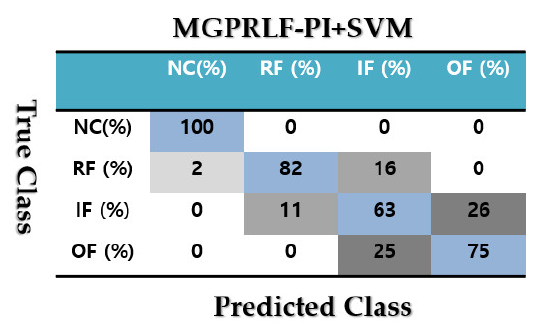
Figure 11. The average accuracies of crack identification using the MGPRLF-PI+SVM technique. Based on the comparison of Figures 7, 9, and 11, the average sensitivities of the pro- posed ADT+SVM, MGPRLF-RPI+SVM, and MGPRLF-PI+SVM techniques are 95.75%, 90.25%, and 80%, respectively. Therefore, the proposed method has improved the crack identification by 5.5% compared to MGPRLF-RPI+SVM and 25.75% compared to